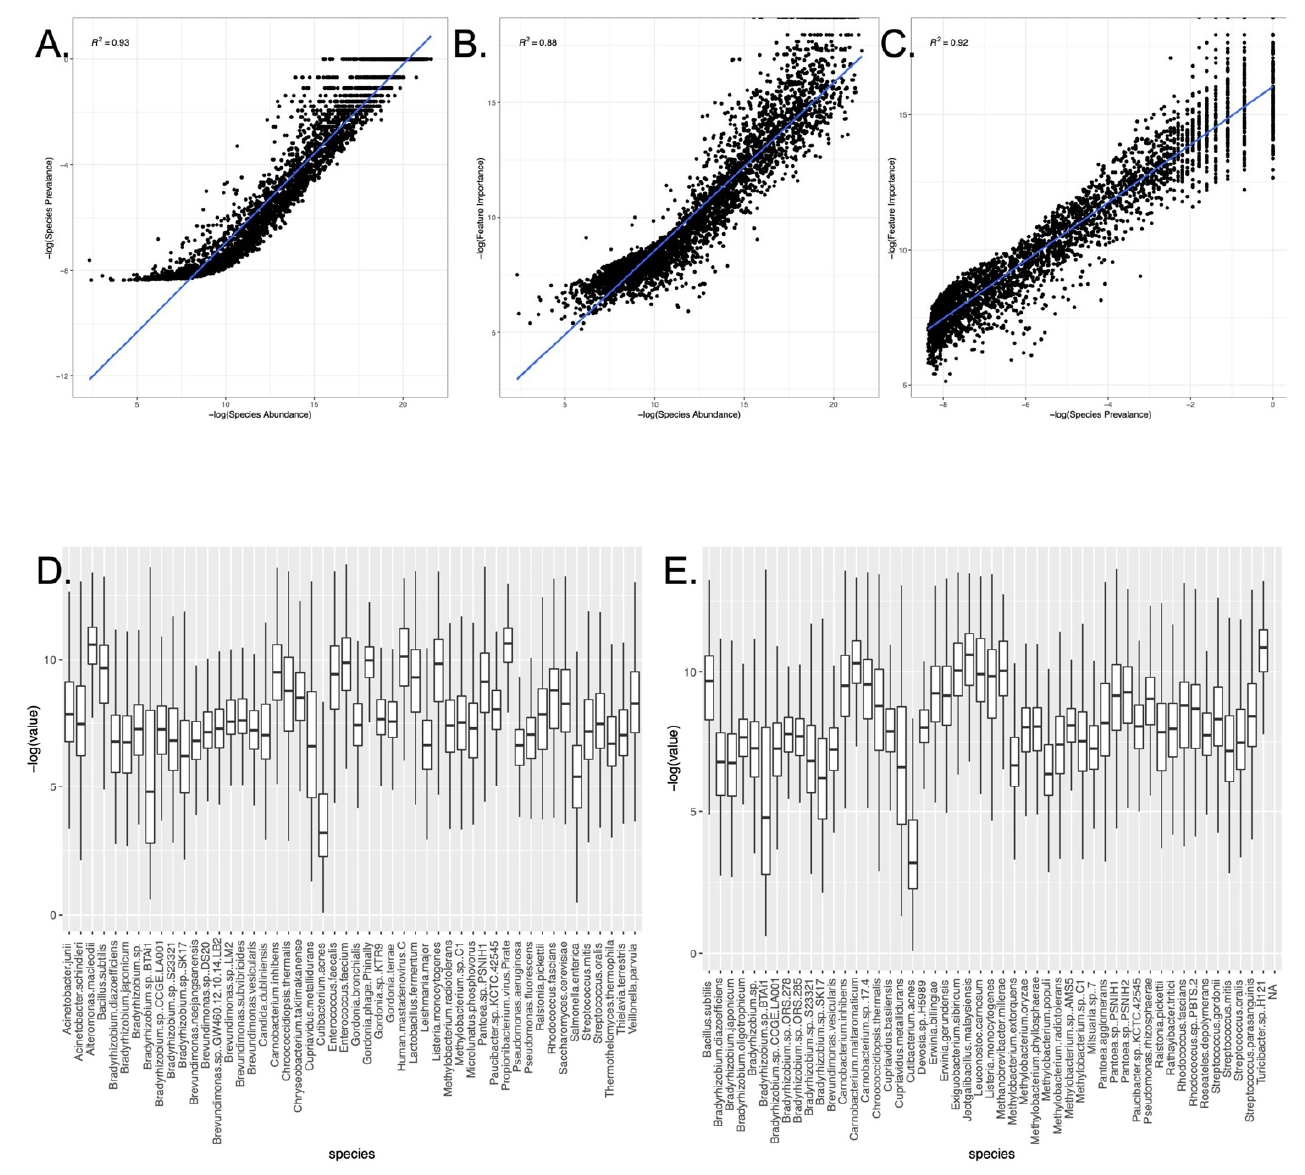
Figure 3. Bioindicator Species and their association with other metrics. ( A – C ): The feature importance (weight assigned to bioindicator species) of the microbes as a bioindicator for cities, species prevalence (number of samples the species is present in), and species abundance (relative abundance of species across all samples) shows a linear relationship when plotted against one another ( D ) Boxplot depicting the abundance of the top 50 bioindicator microbial species for cities in the original MetaSUB data ( E ) Boxplot depicting the abundance of the top 50 bioindicator microbial species for the continent in the original MetaSUB data.